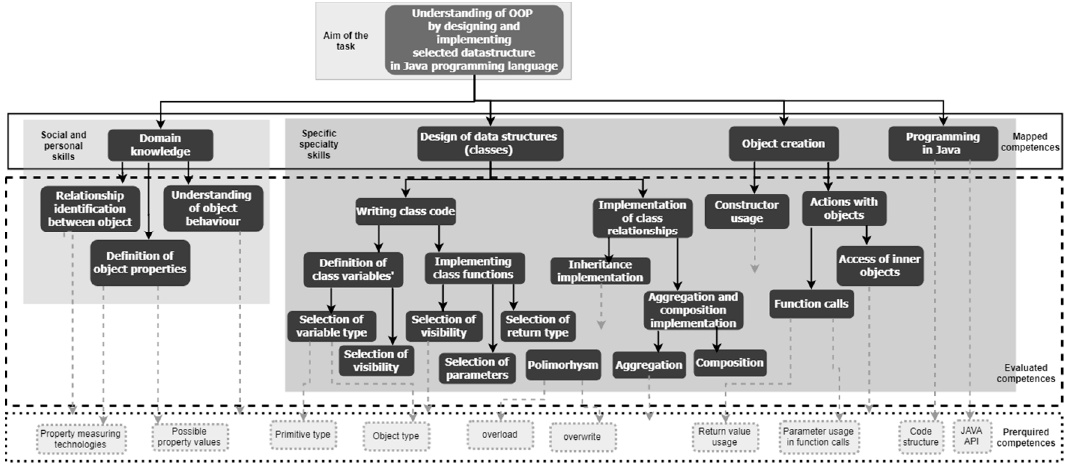
Figure 6. Example of competency tree for object-oriented programming (OOP) course test, dedicated to evaluating students’ understanding of OOP by design and implementation of selected data structure in